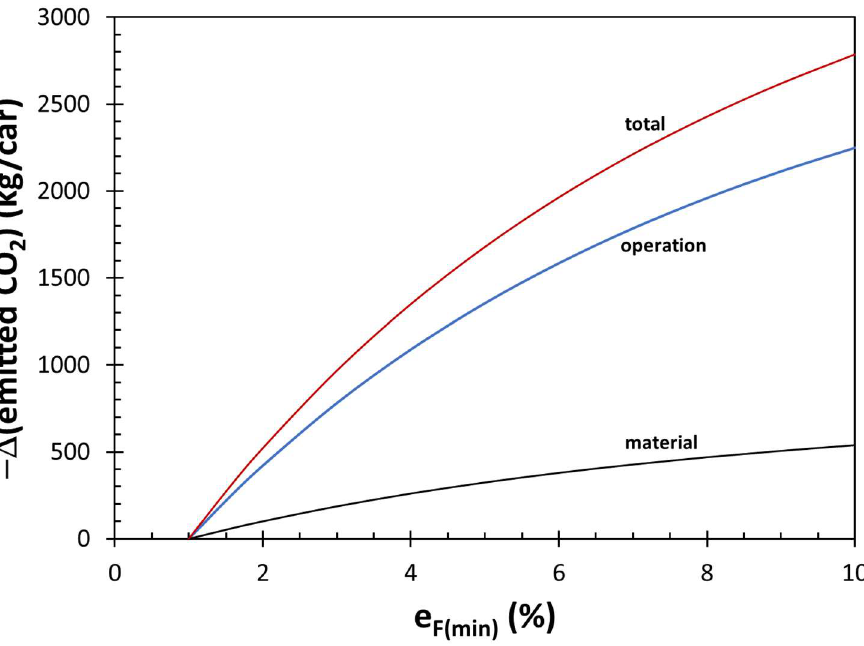
Figure 6. The change in the contribution of the car to CO 2 in the atmosphere as a function of the elongation requirement.